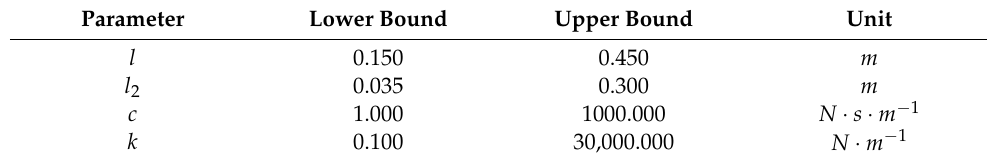
Table 2. Parameter setting of the optimization test.